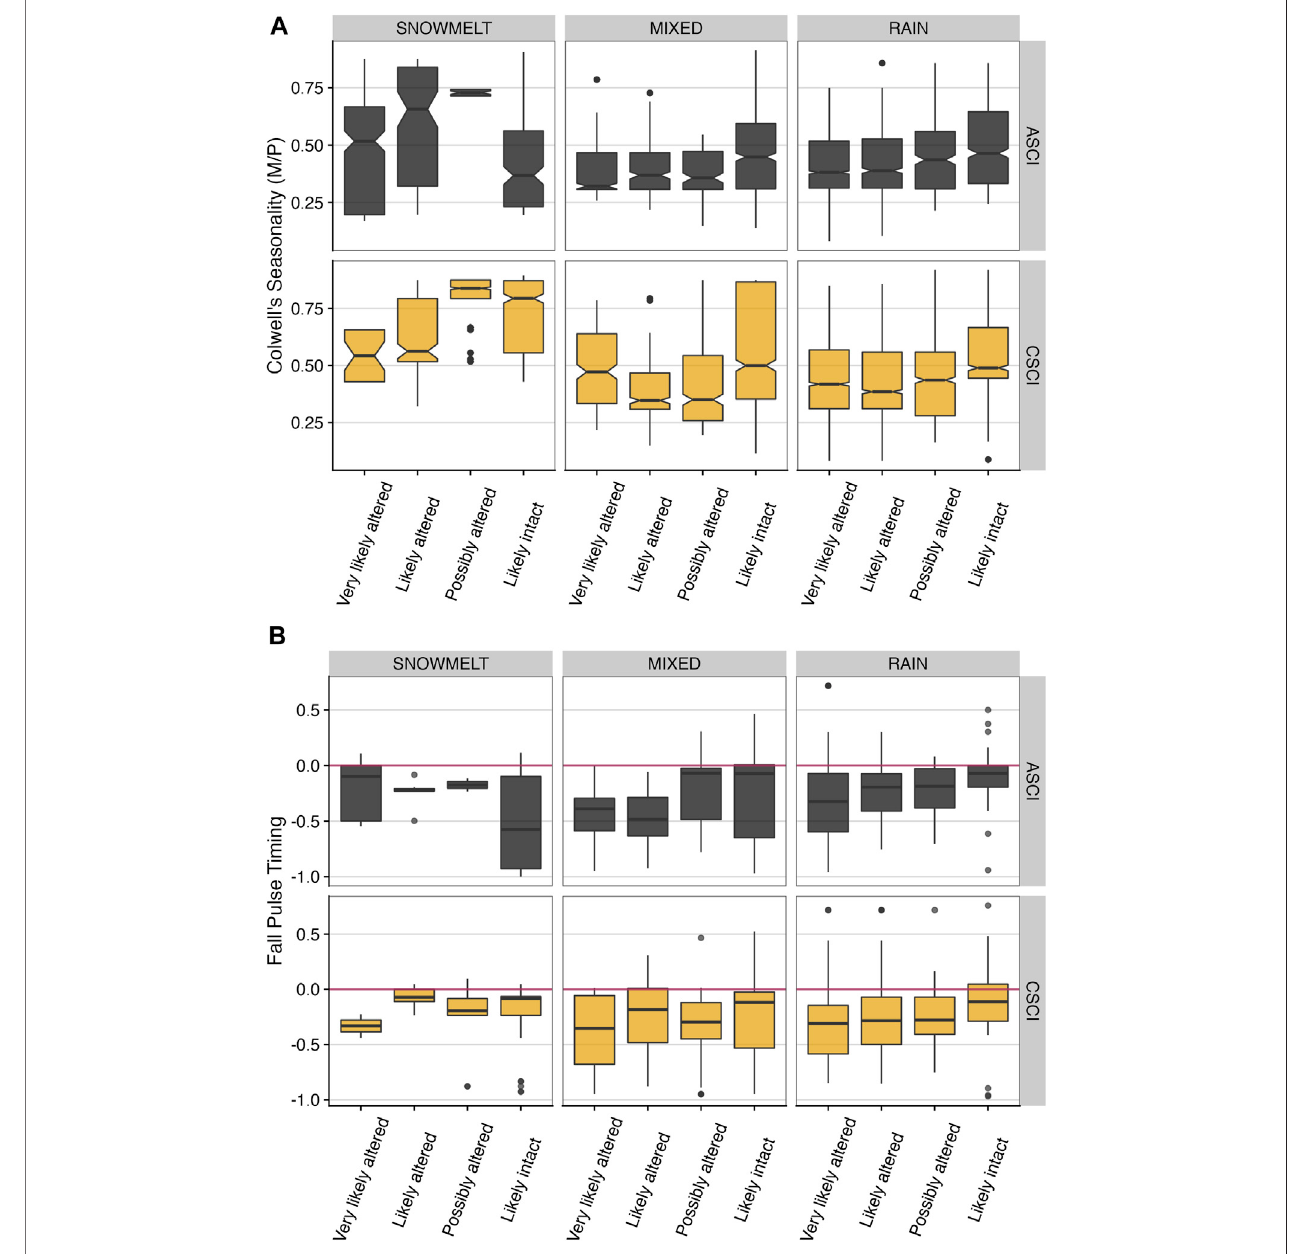
medians are signi fi cantly different (see McGill et al. (1978). (B) Fall pulse timing values (normalized as delta hydrology) versus binned ASCI and CSCI values (based on thresholdsfrom Mazor et al.(2016) and Theroux etal.(2020) forallpaired siteby streamclass. The red zerolinedelineates departure from expected reference fl